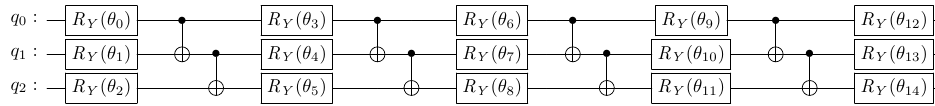
Figure 3: Illustration of the R = N L